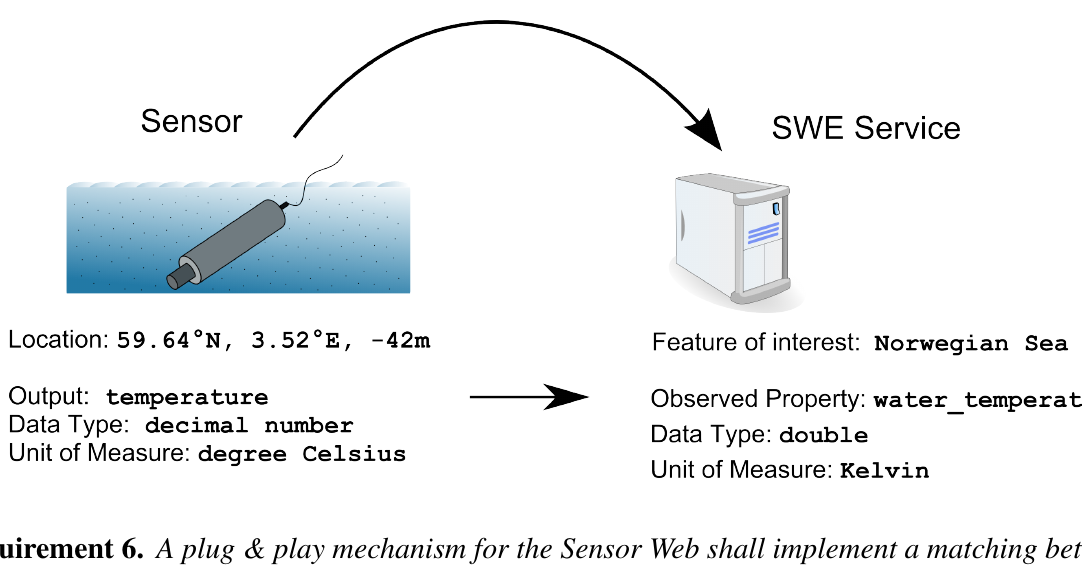
Figure 4. Matching between sensor and service